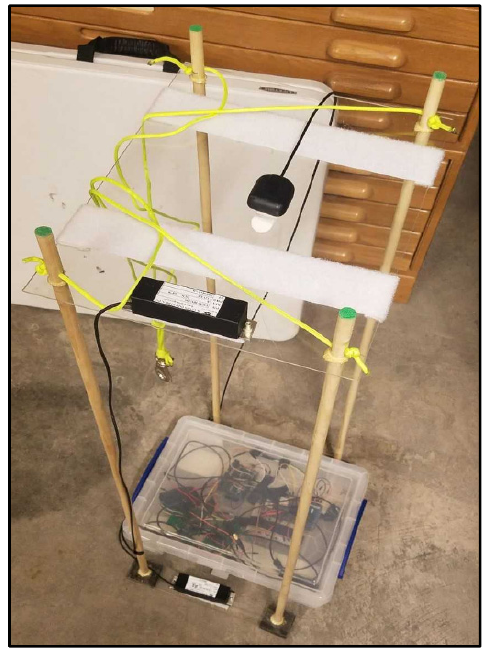
Figure 3. The initial housing design for the magnetic gradiometer.